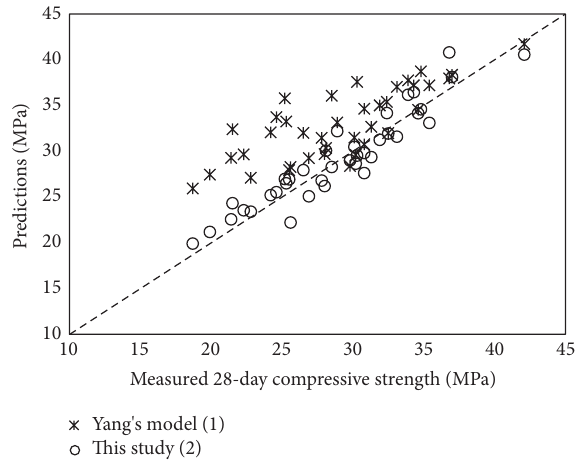
Figure4:Comparisonsofpredictedandmeasured28-daycompres- sive